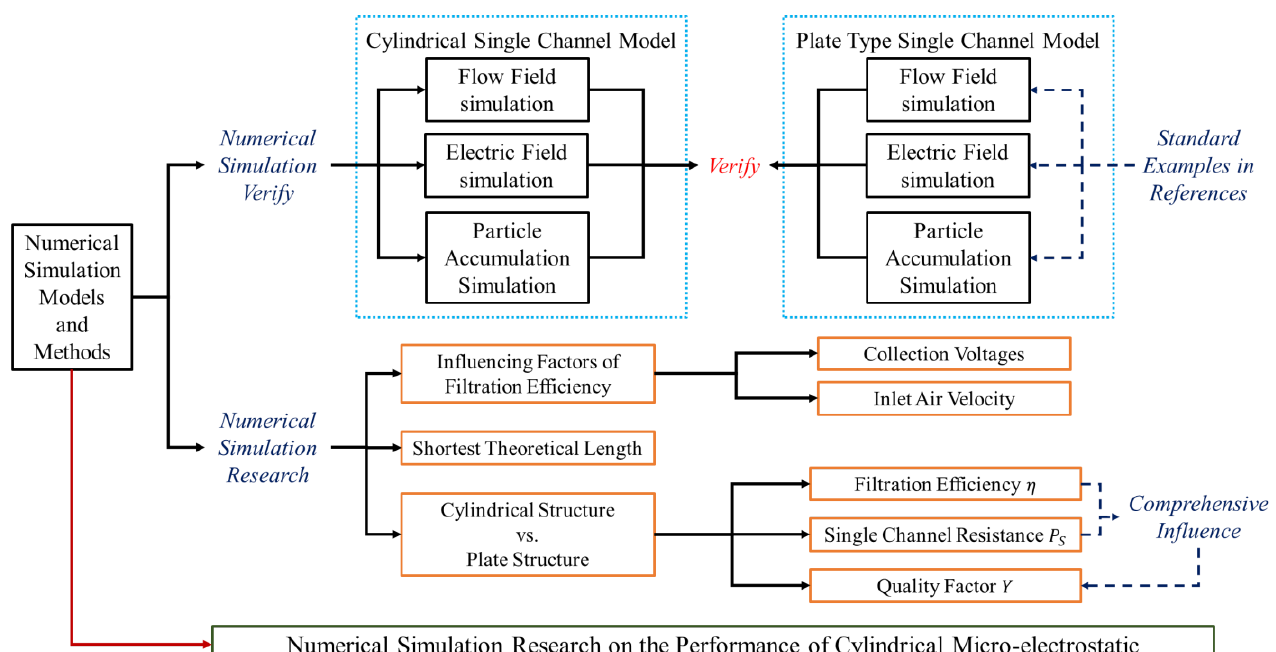
Figure 2. Schematic diagram of the research method.